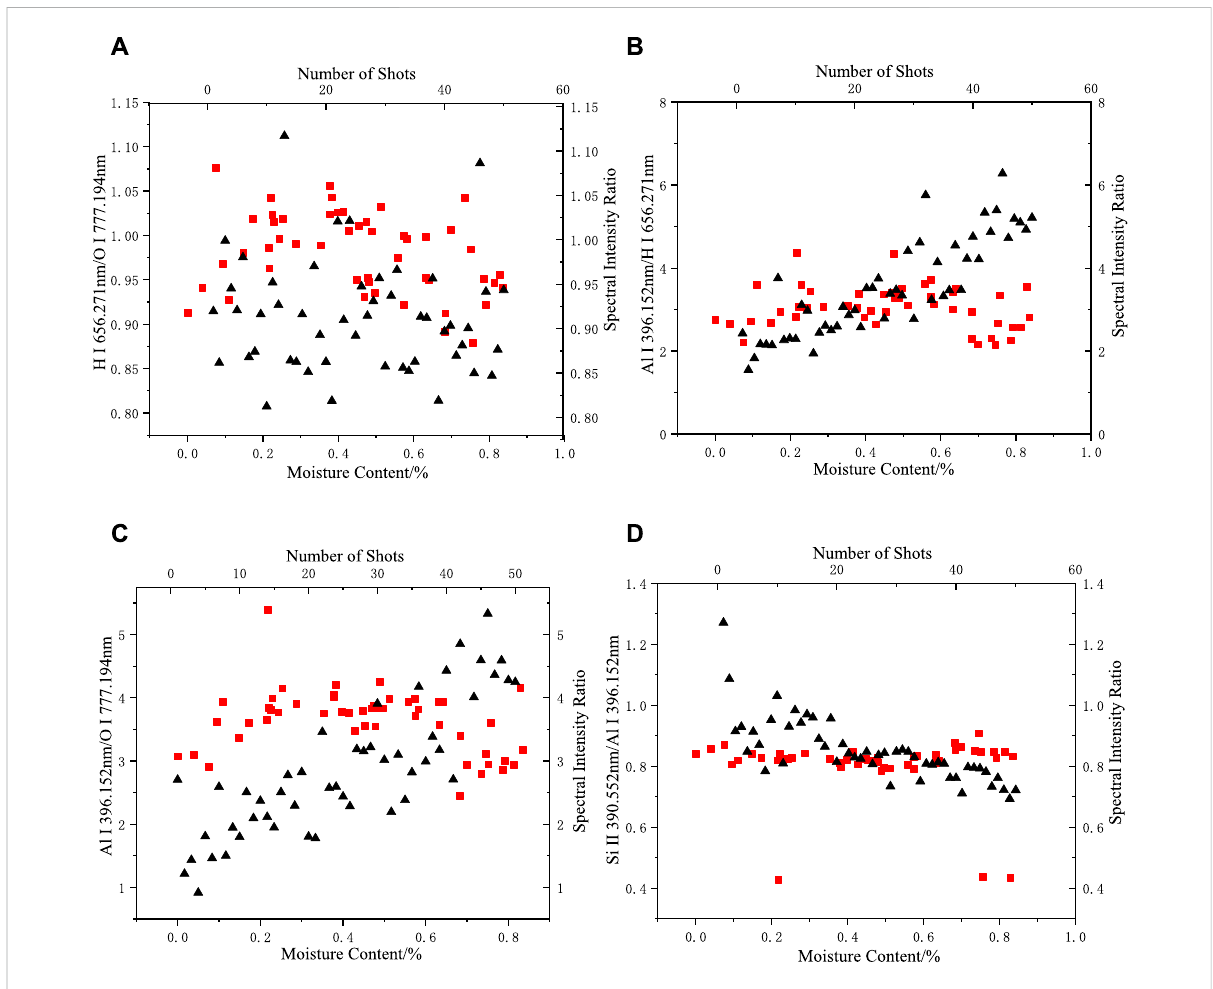
FIGURE 8 Changes in the spectral intensity ratio with moisture contentand number of shots in an air environment: (A) H I 656.271 nm/O I 777.194 nm, (B) AlI396.152nm/OI656.271nm, (C) AlI396.152nm/OI777.194nm, (D) SiII390.552nm/AlI396.152 nm(thesquarerepresentsthechangeofspectral intensity ratio with moisture content, and the triangle represents the change of spectral intensity ratio with the number of